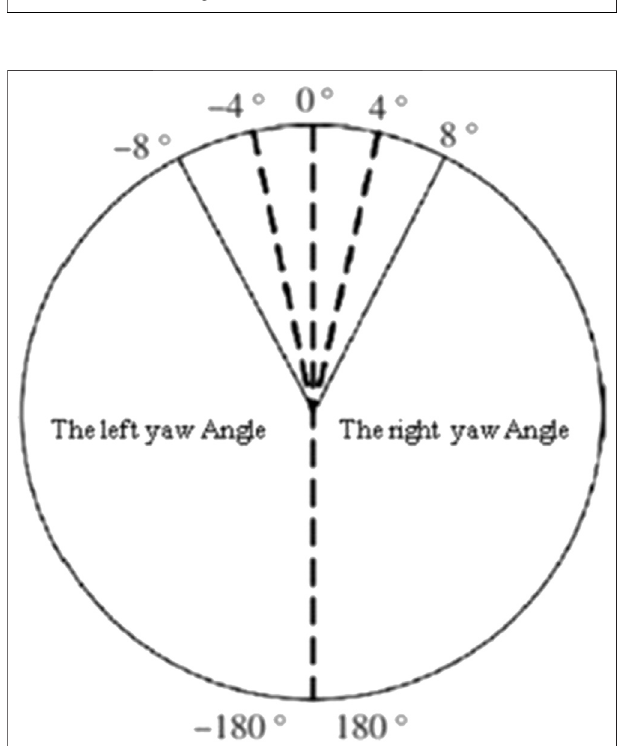
FIGURE 7 | Schematic diagram of automatic yaw control